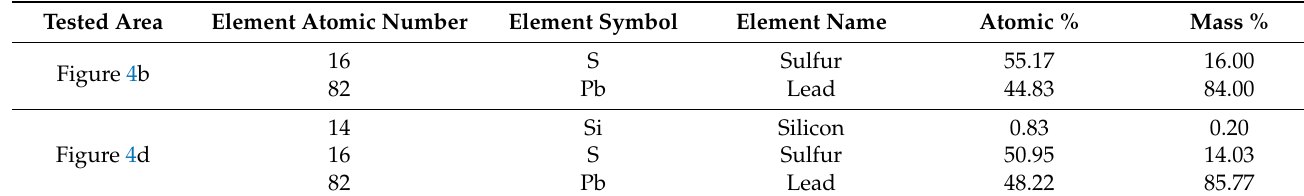
Table 4. Chemical analysis of the used galena, employing the EDS unit of the SEM.